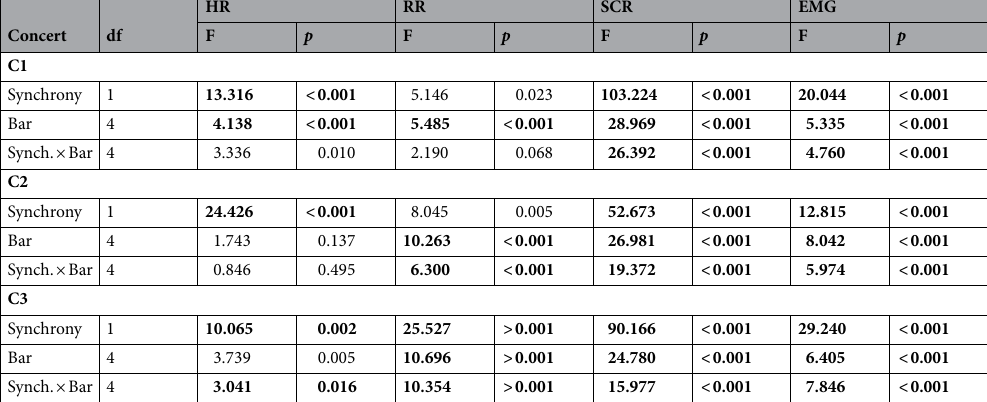
Table 1. ANOVA tests for linear models comparing physiology in 5 bar windows for Synchrony (HS/LS) across correlation windows in terms of Bar (0–4), calculated with the Anova function from the car package in R. Bonferroni-corrected threshold for significant effect was 0.05/12 = 0.004. Values highlighted in bold are statistically significant after Bonferroni corrections for multiple